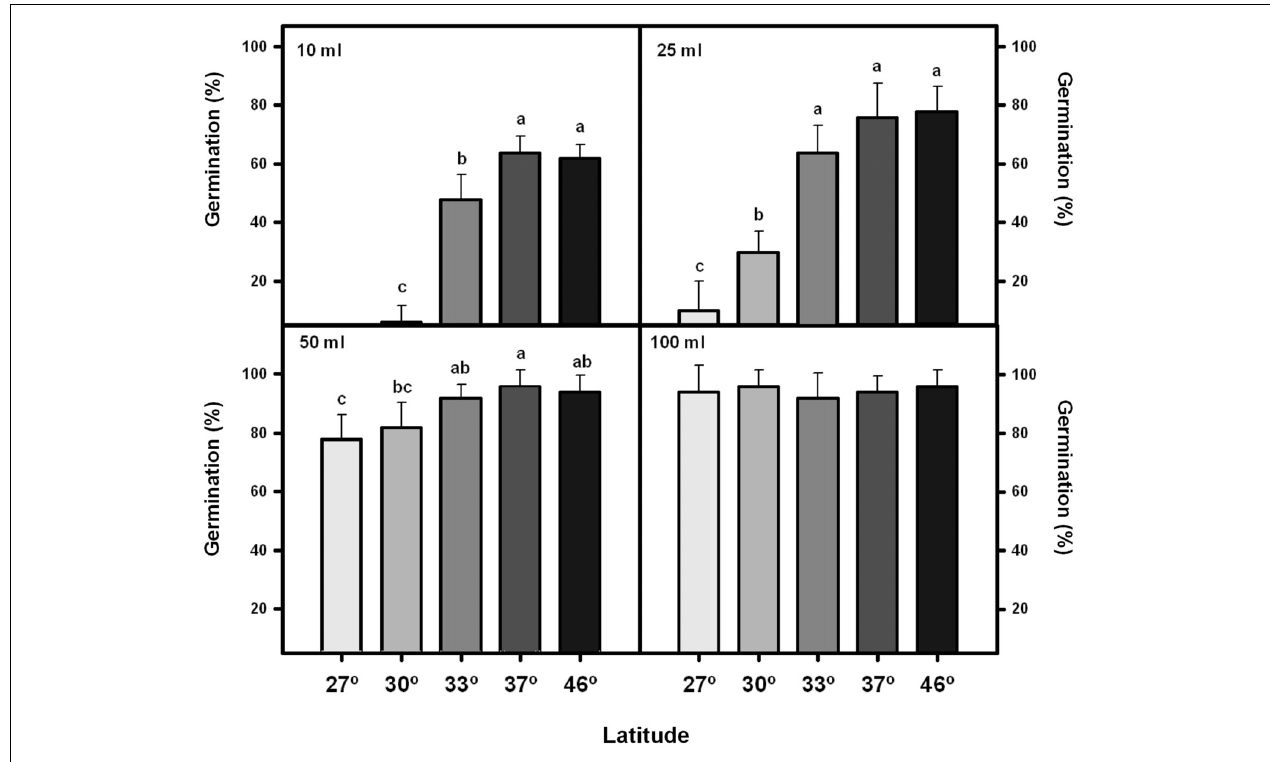
FIGURE 3 | Germination percentage of Taraxacum officinale seeds collected from five localities along a latitudinal gradient and exposed to different amounts of water irrigation treatments. Mean values ( ± 2 SE) in germination of five populations of every locality along the latitudinal gradient are shown. Significant differences between localities are denoted with different letters ( a posteriori Tukey test α =